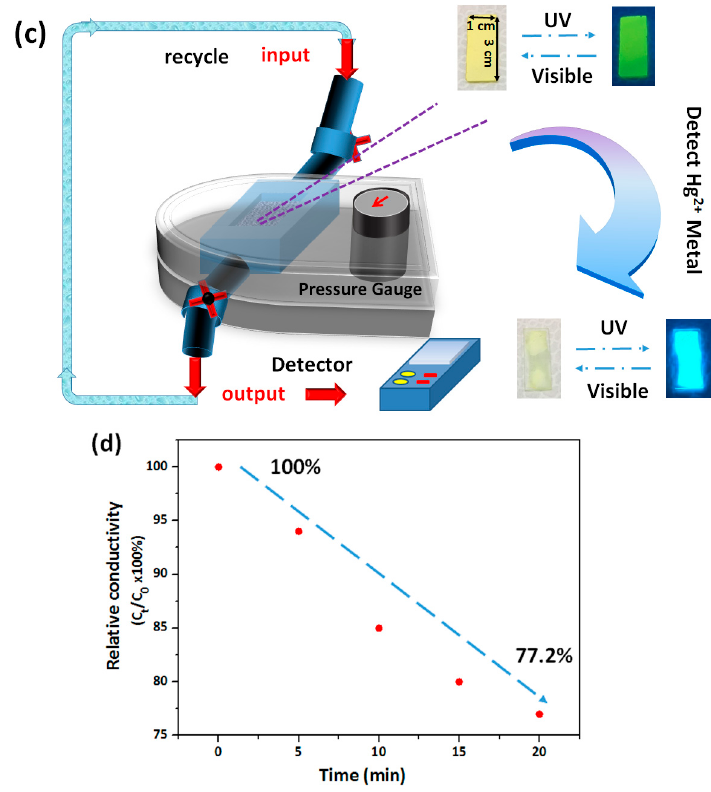
Figure 11. ( a ) CIE coordinates of P2-5% ES nanofibers in pH 7 aqueous solutions and after the detection of Hg 2+ at 10 − 2 M aqueous solutions. ( b ) Confocal microscopy images of the ES nanofibers. All the inset figures show corresponding photographs recorded under UV light. ( c ) Schematic of a sensory filter microfluidics system for real-time metal ion sensing using an ES nanofiber membrane. ( d ) Relative conductivity versus time of the prepared Hg 2+ solution in the microfluidics system.